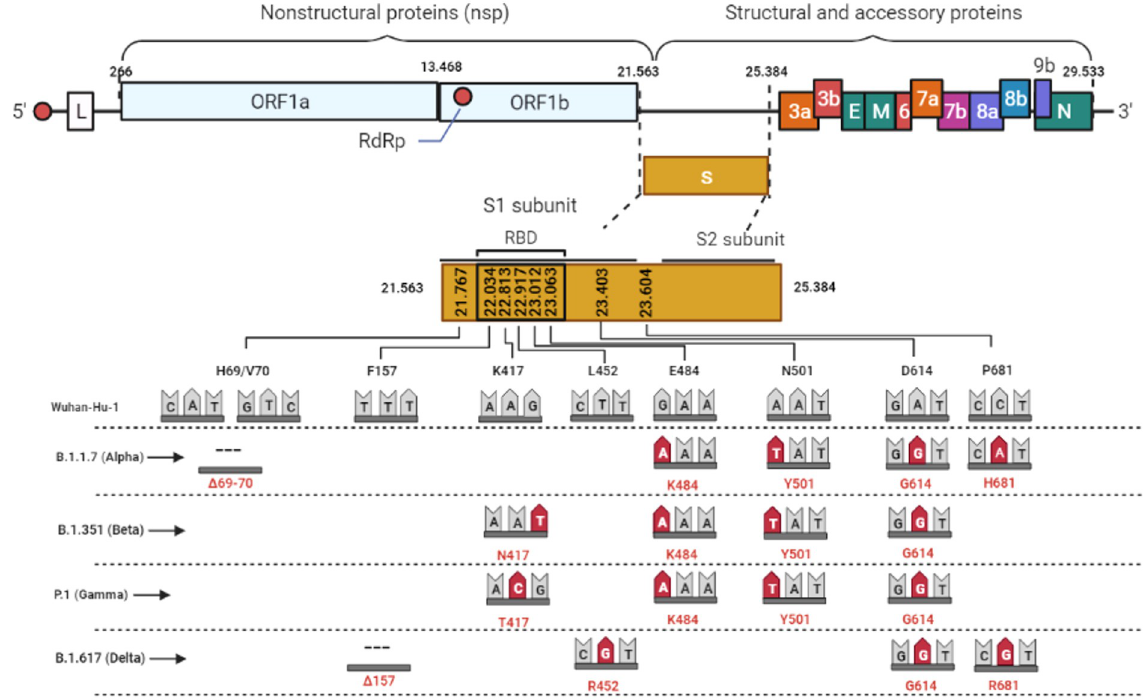
Fig 1. Graphical representation of the SARS-CoV-2 genome. Highlighted are the S gene and the main mutations described in the variants of concern. As a measure of comparison, the length of the S gene is already equivalent to the one of the whole Dengue virus genome.